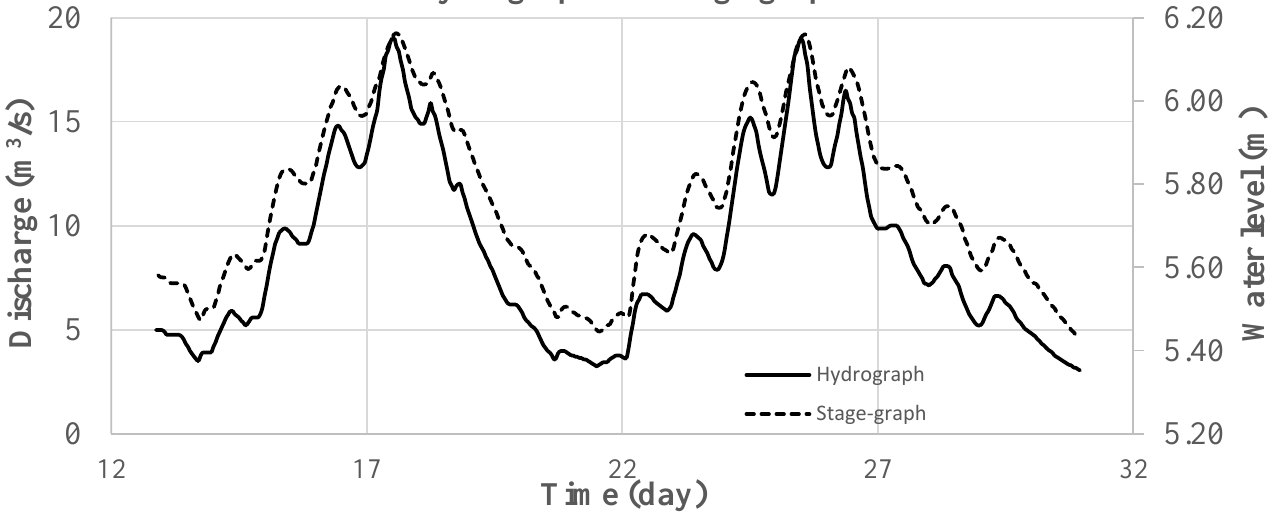
Figure 6. Selected reach of East Fork River. Solid circles represent the approximate locations of bed samples.